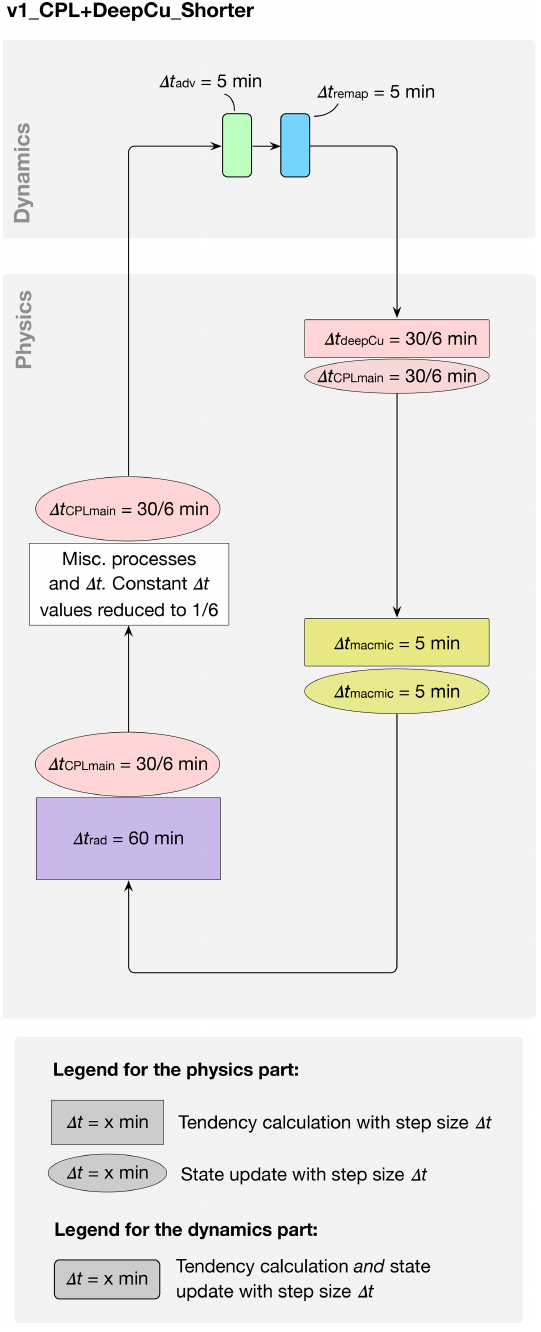
Figure 13. Schematic showing the time step sizes used in simula- tion v1_CPL + DeepCu_Shorter. The color coding follows Fig. 1a. Further details can be found in Sect. 4.3.1. The simulation setup is summarized in Tables 1 and A1.